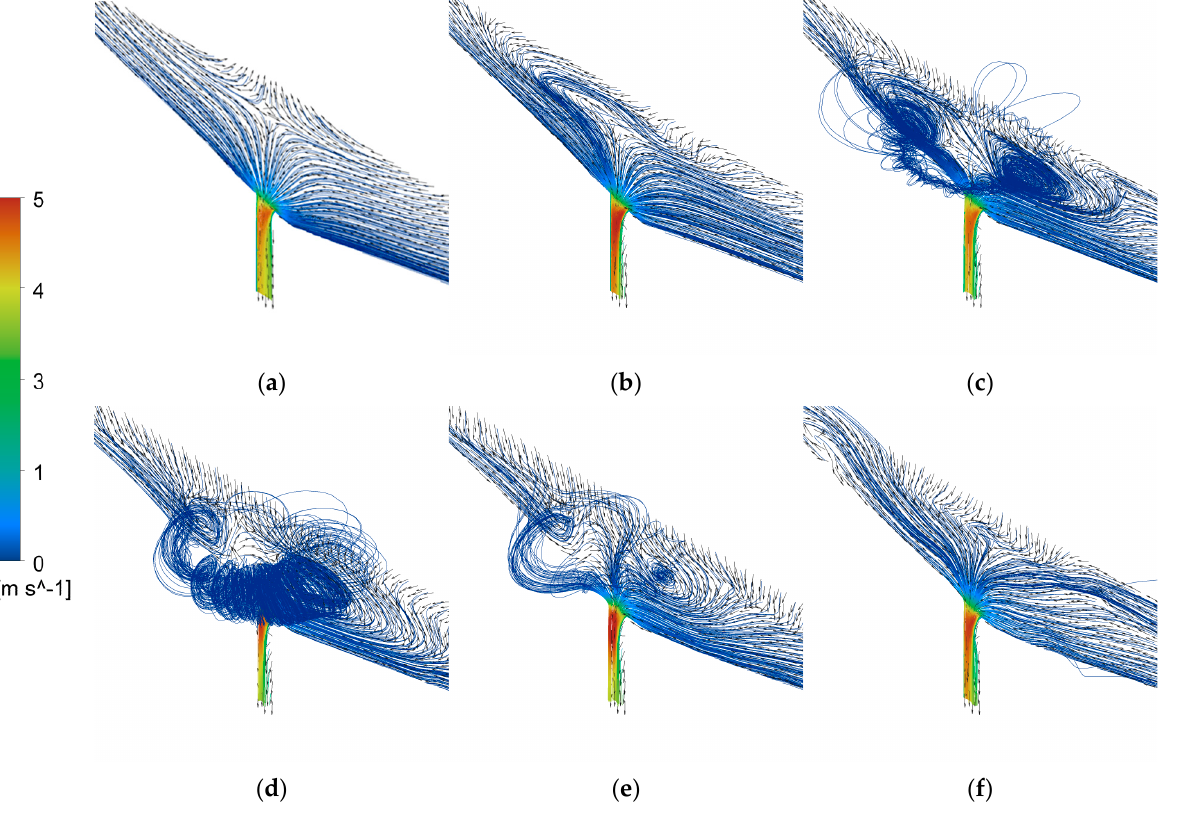
Figure 5. Velocity streamline diagram at a converter angle of 100°: ( a ) 1 s; ( b ) 30 s; ( c ) 67 s; ( d ) 72 s; ( e ) 75 s and ( f ) 80 s. ( e ) 75 s and ( f ) 80